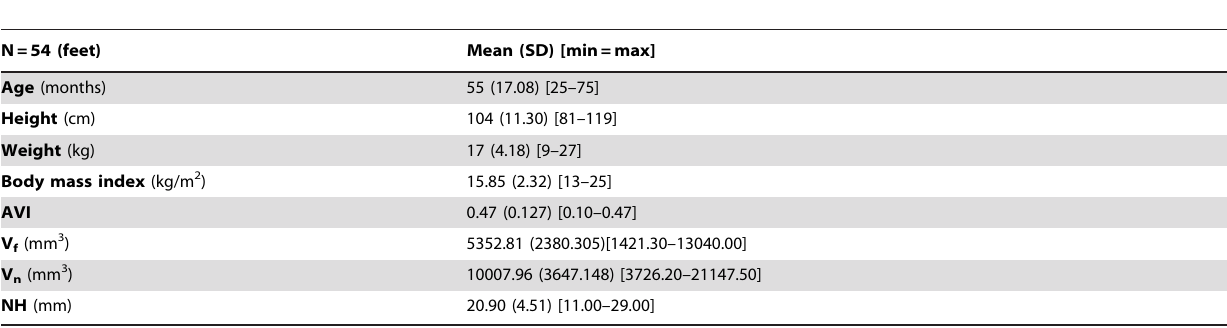
Table 1. Subject characteristics and descriptive results of static foot arch variables, with the values presented as means (SD) and